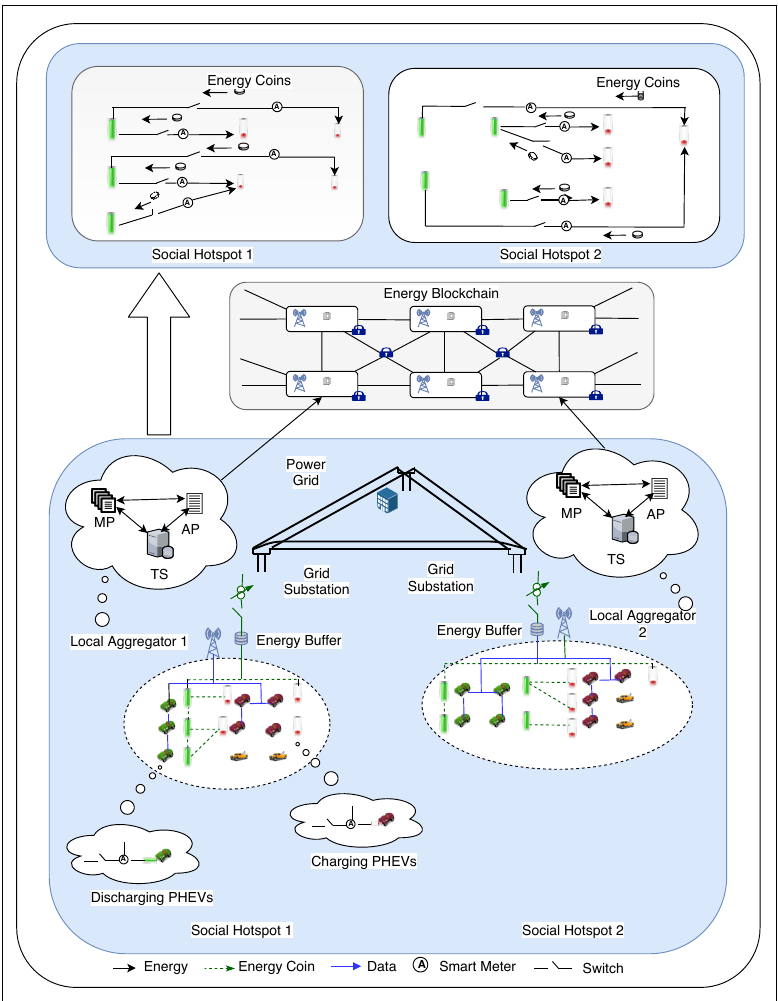
Figure 5. Architecture for energy trading in electric